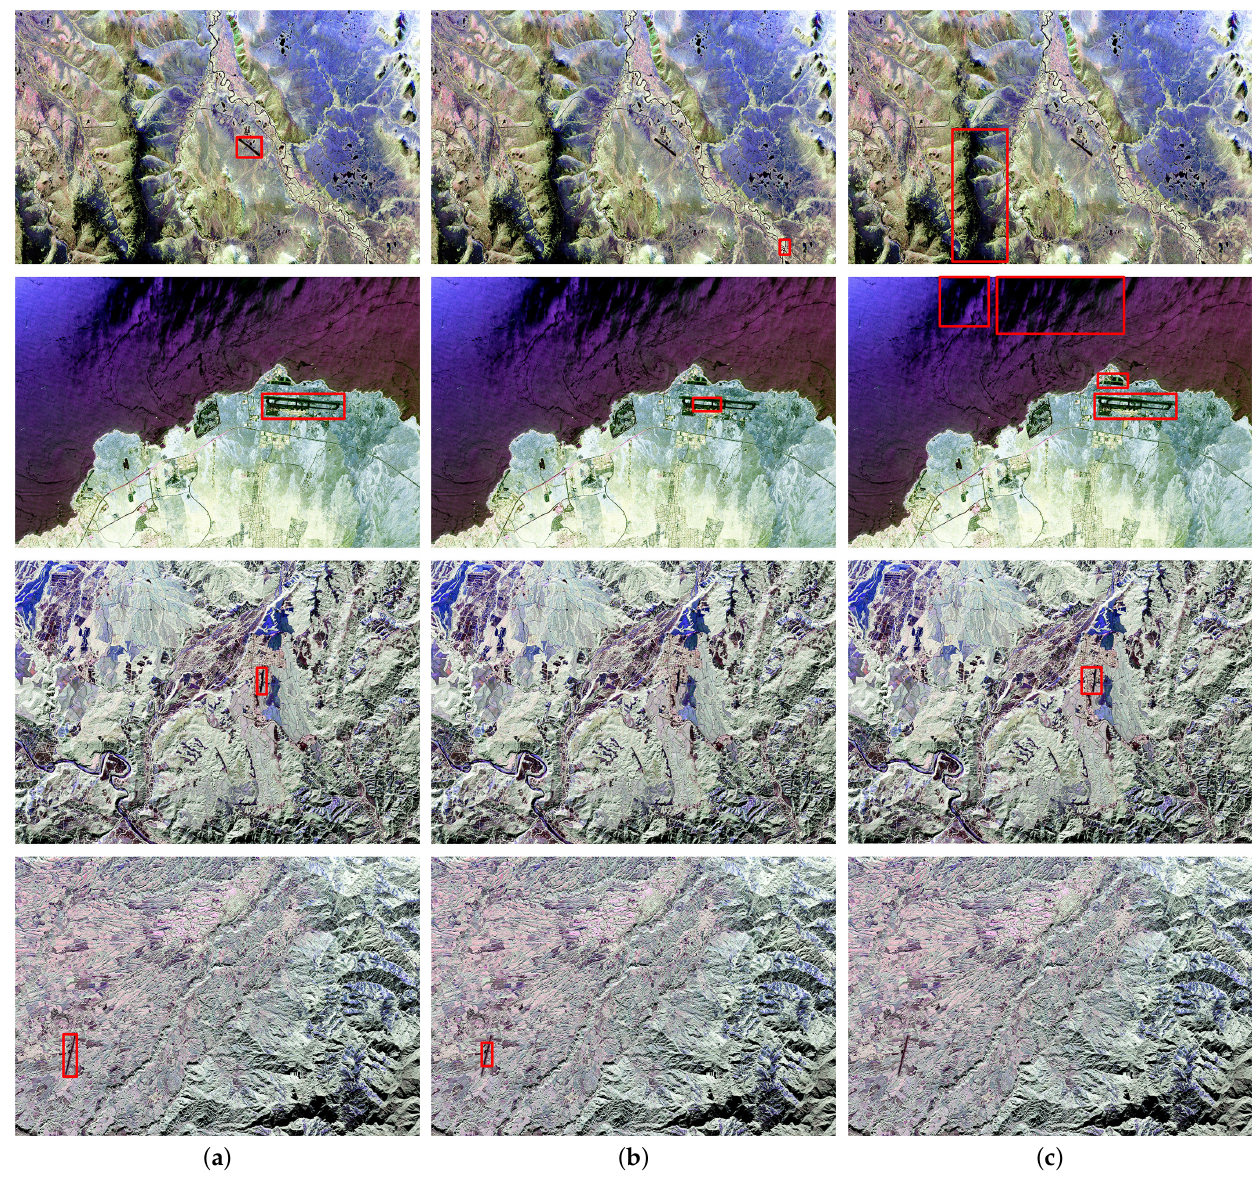
Figure 13. Comparison of airport detection results. ( a ) Ours. ( b ) CSA-SOACM. ( c )